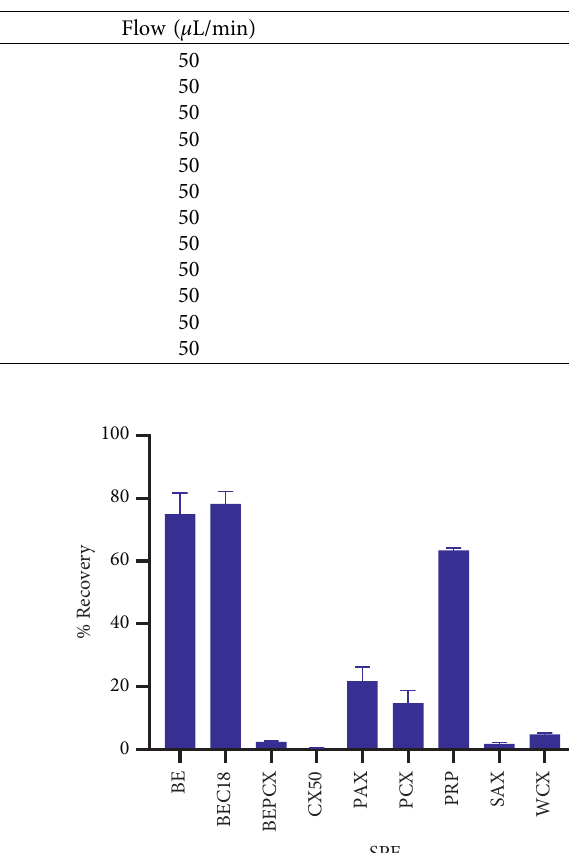
Table 1: Gradient programme on the Dionex Ultimate HPLC system using an Ace 5 C8-300 column (250 mm × 1mm).